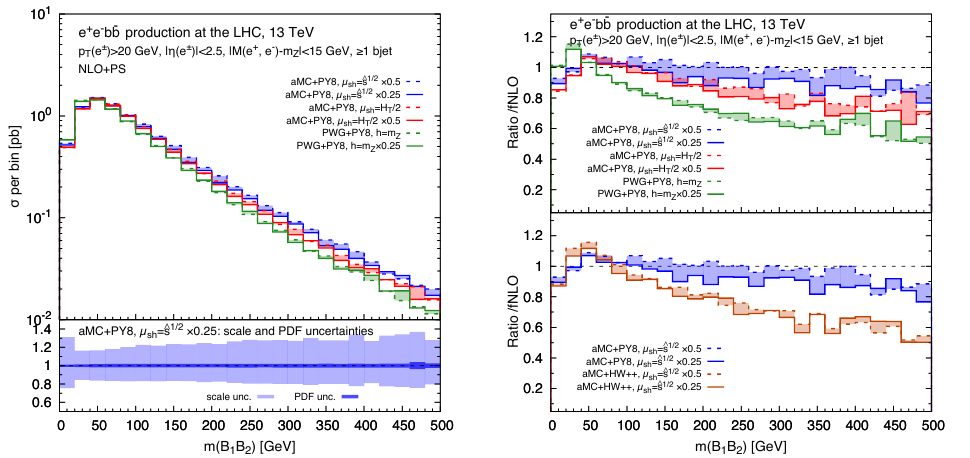
Figure 21 . Invariant mass distribution of the B hadrons pair in association with at least 1 b jet.